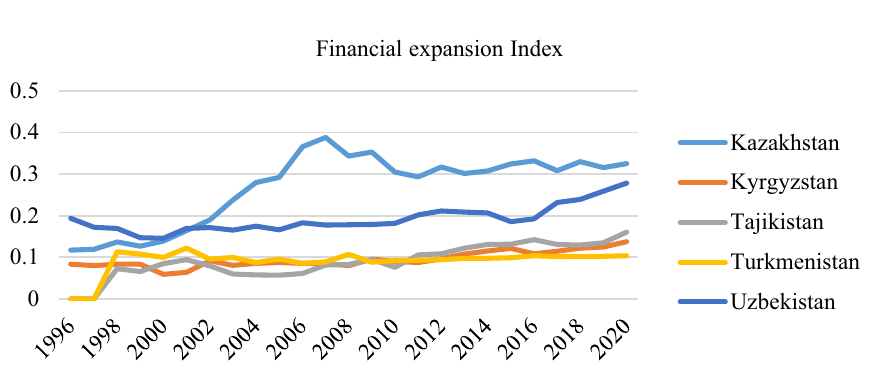
Fig. 2 Financial expansion index in Central